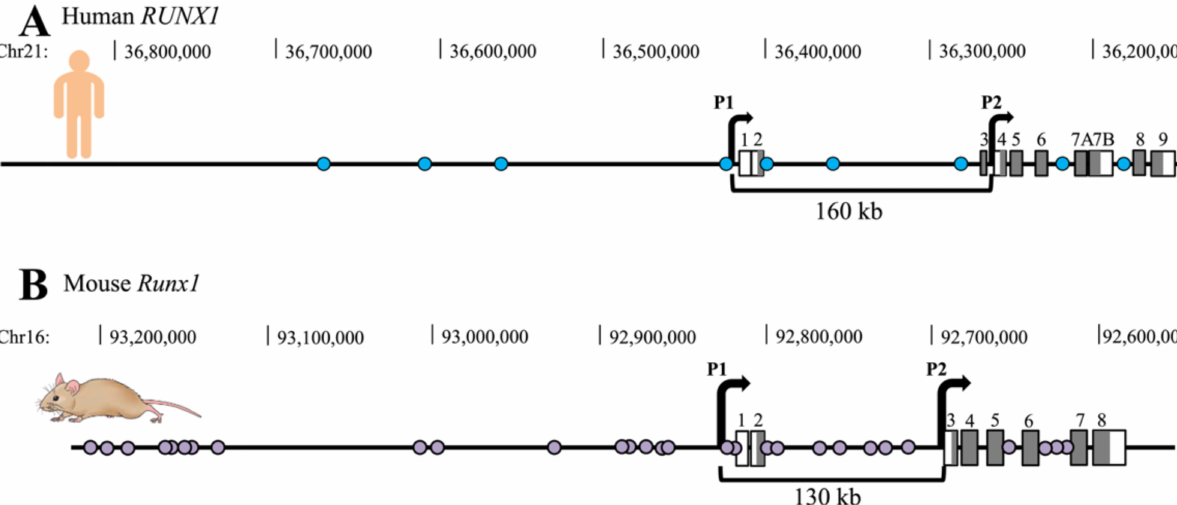
Figure 1. Schematic representing the approximate genomic location of Runx1 regulatory elements (REs) identified to date in human and mouse. REs are annotated with circles; grey boxes annotate exons of Runx1 . The two Runx1 promoters are represented by black right angled arrows ( A ) Genomic location of the 9 previously identified Human RUNX1 REs. ( B ) Genomic location of the 29 previously identified mouse Runx1